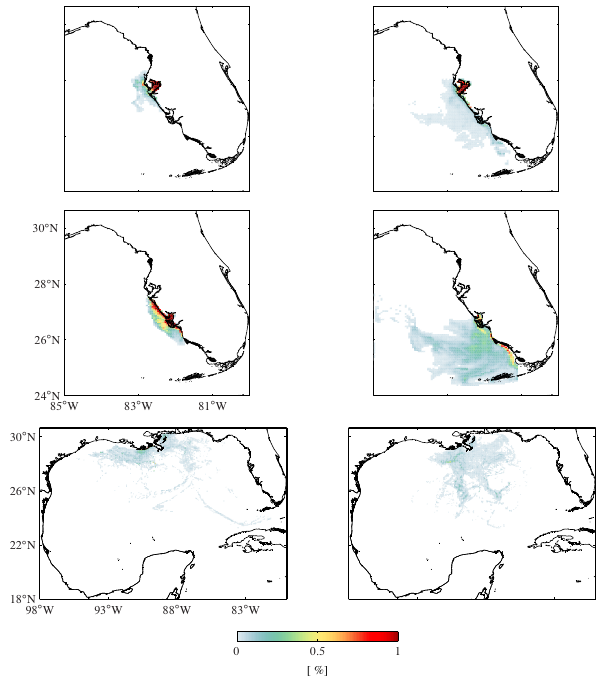
Fig. 7. Particle concentration (expressed as percentage of total particles) maps during conditions of maximal onshore (left panels) and offshore (right panels) of the CSTB on the WFS. These maps were constructed using particles released every other day over the course of 30 d in each of the aforementioned conditions over the whole period 2000–2007 on the surface layer in Tampa Bay (top panels), Charlotte Bay (middle panels), and the vicinity of the Mississippi River’s mouth (bottom panels).